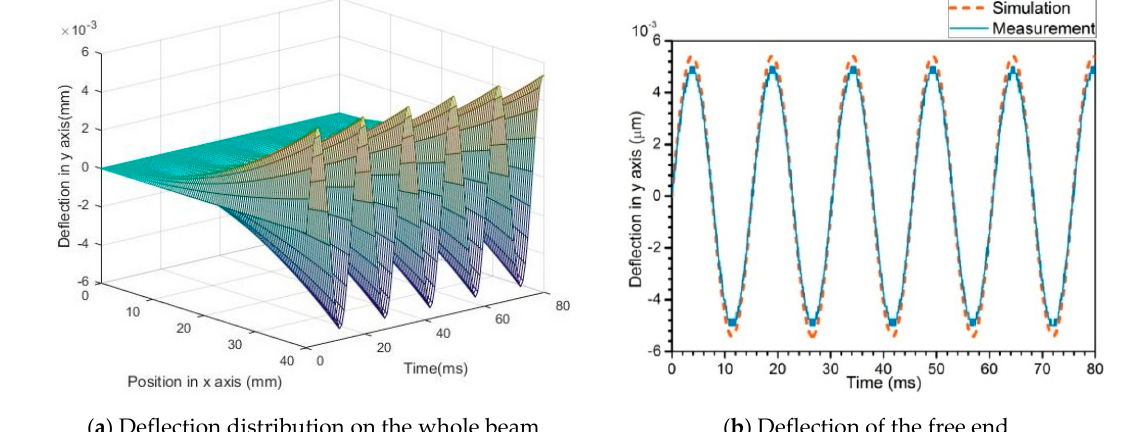
Figure 9. Deflection of the beam.